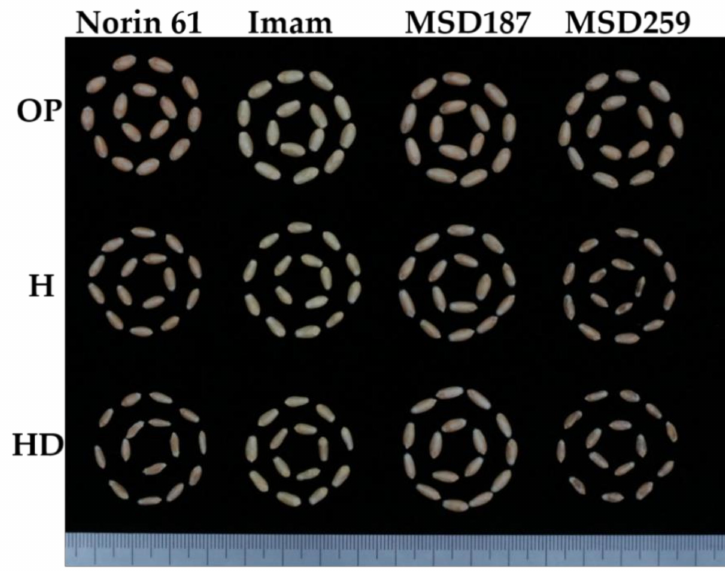
Figure 4. Variations in kernel weight and shape-related traits under optimum (OP), heat(H) and combined heat–drought (HD) conditions. Norin 61: the background of the MSD lines, showed a reduction under H and HD conditions; Imam: check cultivar known as heat tolerant, showed a small reduction; MSD187: showed a slight reduction under H and HD conditions; MSD259: highly sensitive line, showed remarkable reduction under H and HD